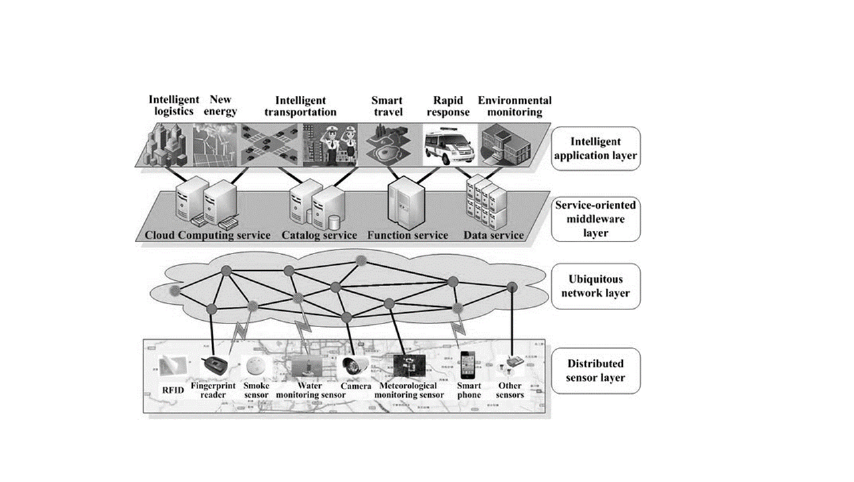
Figure 3. A framework of the smart city based on the Internet of Things